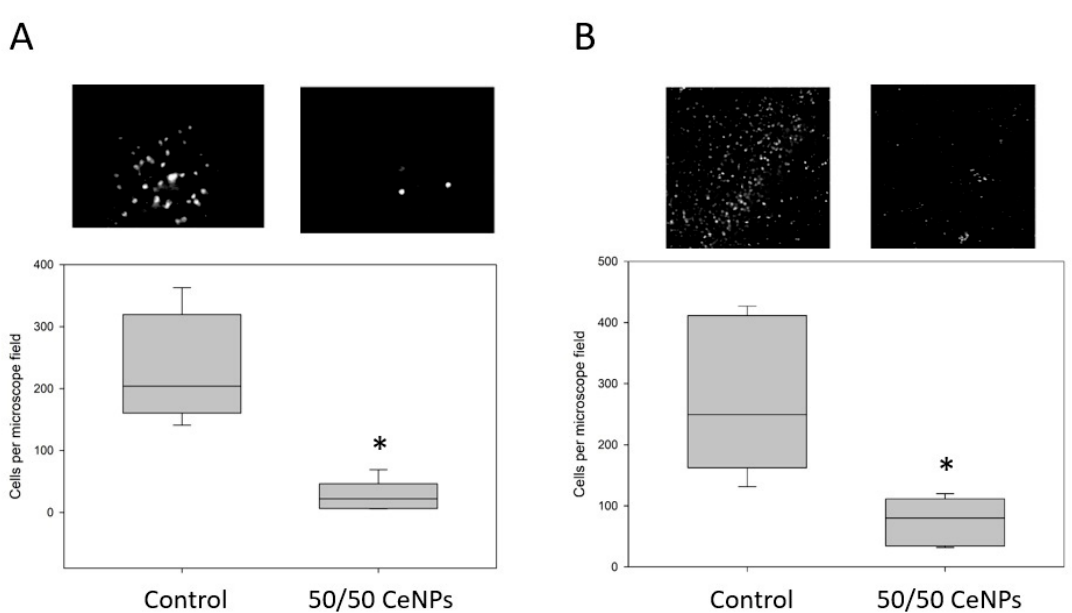
Figure 5. CeNPs stabilized with 50 / 50 CA / EDTA significantly reduce ROS ( A ) and cell death ( B ) in mouse brain slices exposed to ischemia and Ang-II as described in the methods. Values represent the median cell count per microscope field and the interquartile range. Representative fluorescence images from each group are shown above each respective box plot. Statistical significance was determined with the Mann–Whitney Rank Sum Test comparing control vs. 50 / 50 CeNP groups. * p < 0.01, n = 5–6 slices per group.